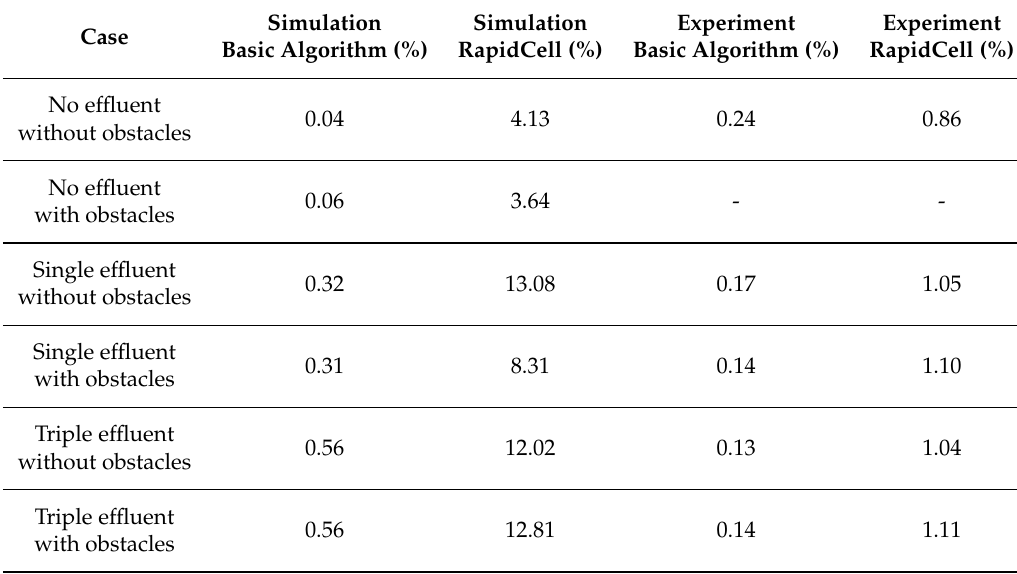
Table 1. Average percentage (AP).